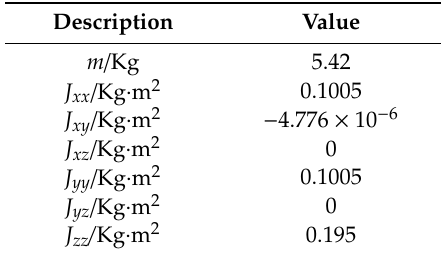
Table 1. Mass and moment of inertia of the floating